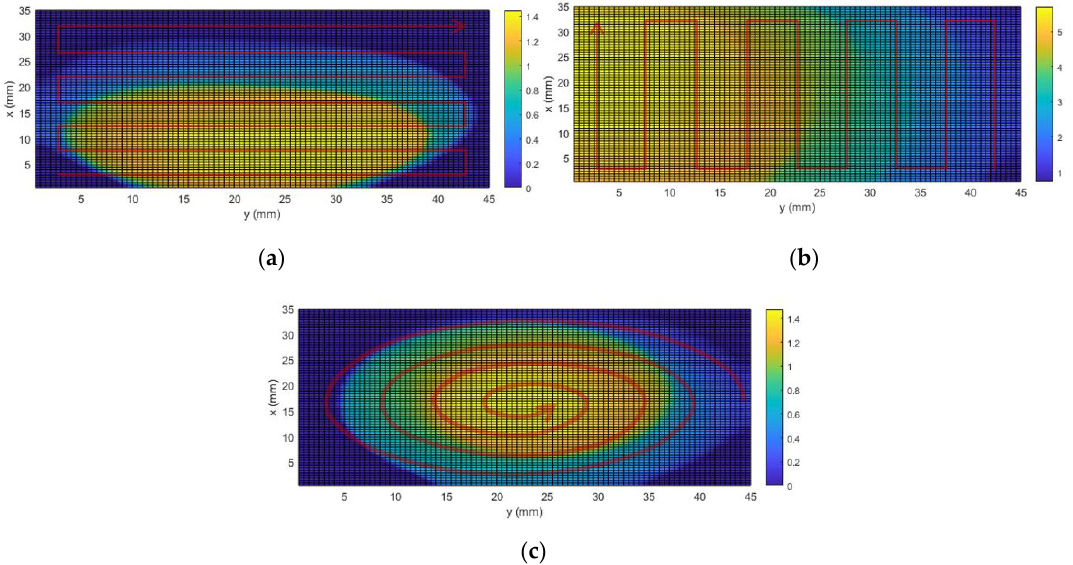
Figure 6. The time at which each point is between melting and degradation temperatures: ( a ) zig-zag trajectory parallel to x ; ( b ) zig-zag trajectory parallel to y ; ( c ) spiral